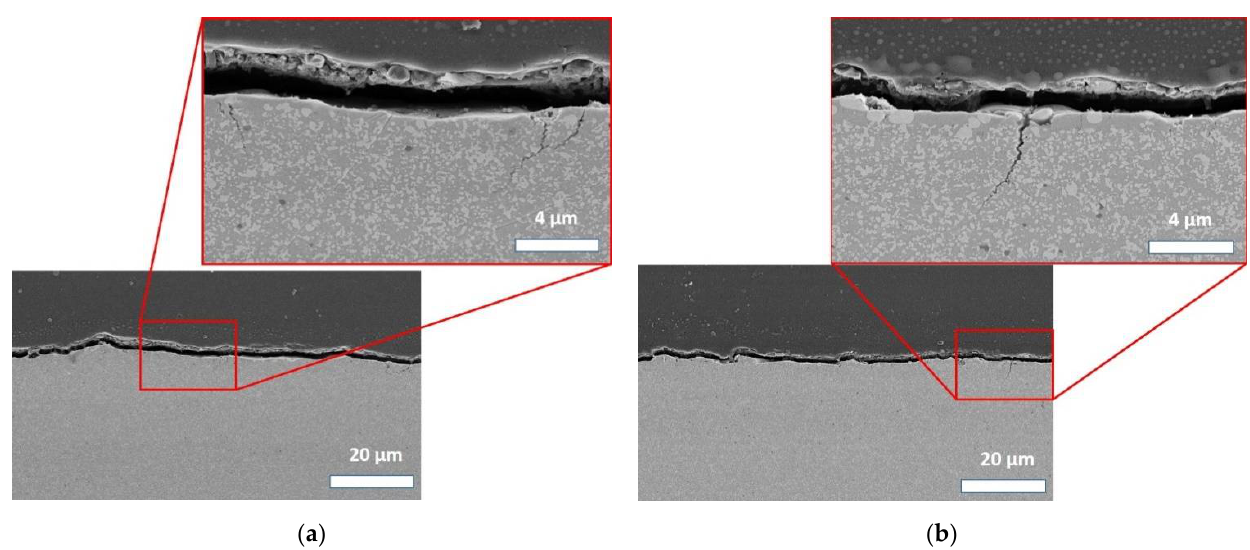
Figure 9. SEM images of cross-cut and polished sections through ED-machined surfaces of 28 WC-1400. Red box: detailed images of cracked regions. ( a ) 28 WC-1400 machined with parameter set EDM 1. ( b ) 28 WC-1400 machined with parameter set EDM 2.